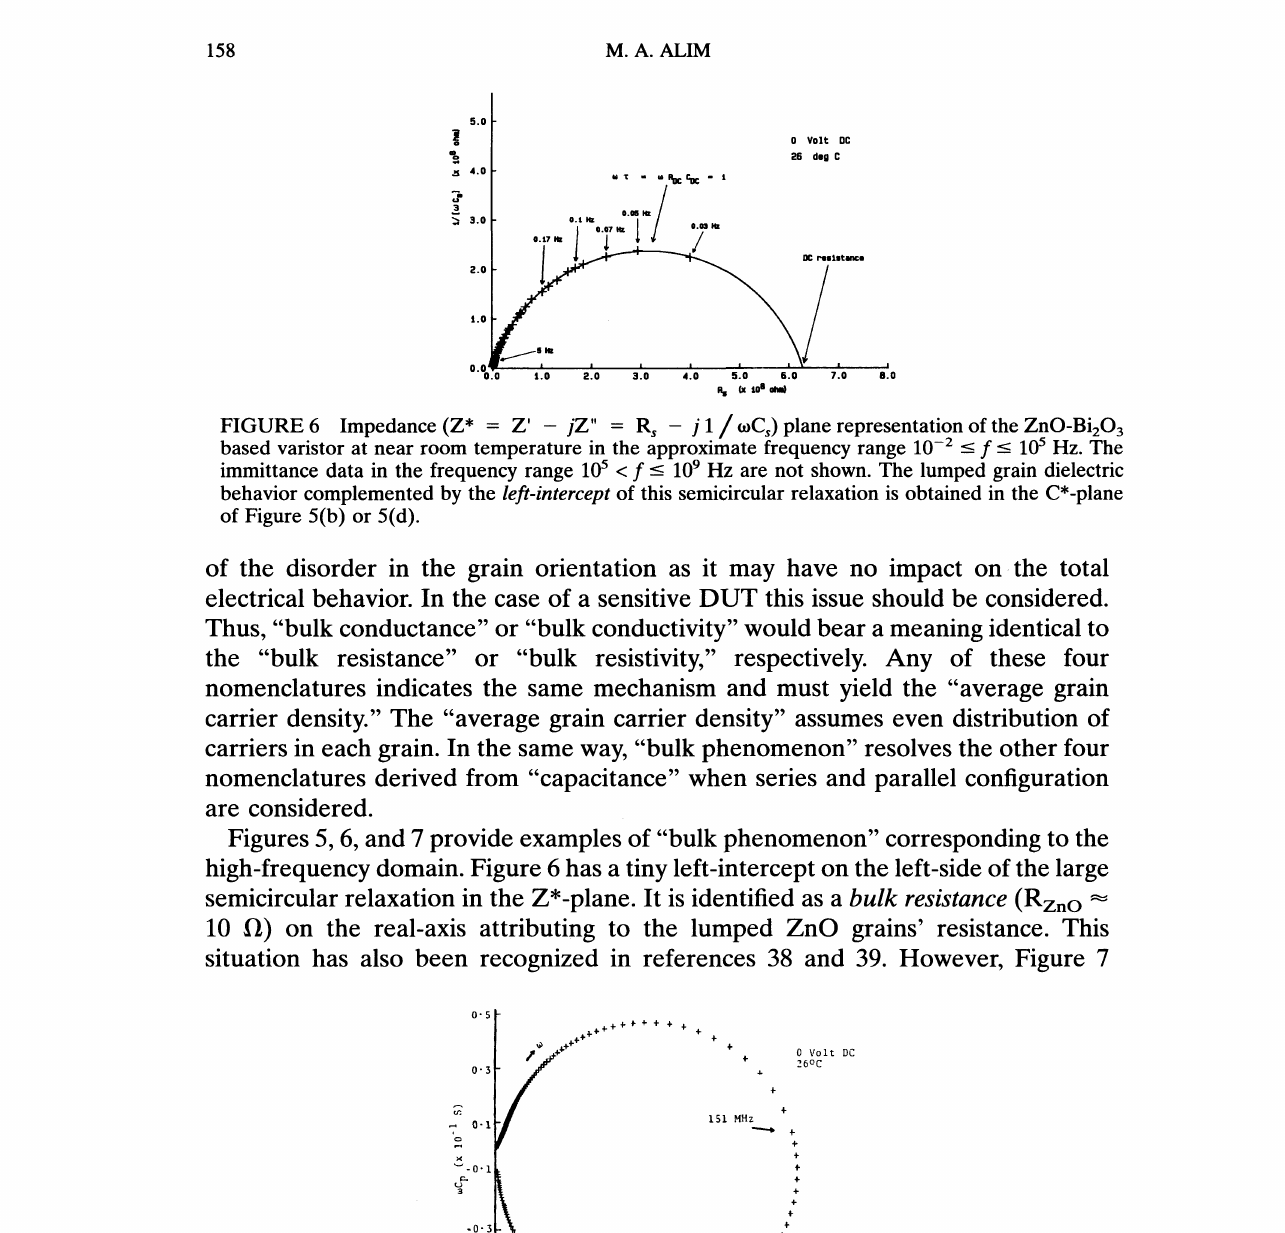
FIGURE 7 Admittance (Y* Y’ + j Y’ Gp + j to Cp) plane representation of the ZnO-Bi203 based varistor at near room temperature in the approximate frequency range 106 --< f --< 109 Hz. The chord of the semicircle or circle passing through x 0, y 0 and parallel to x-axis yields the ’ left-intercept value of RZn o 10 obtained in Figure